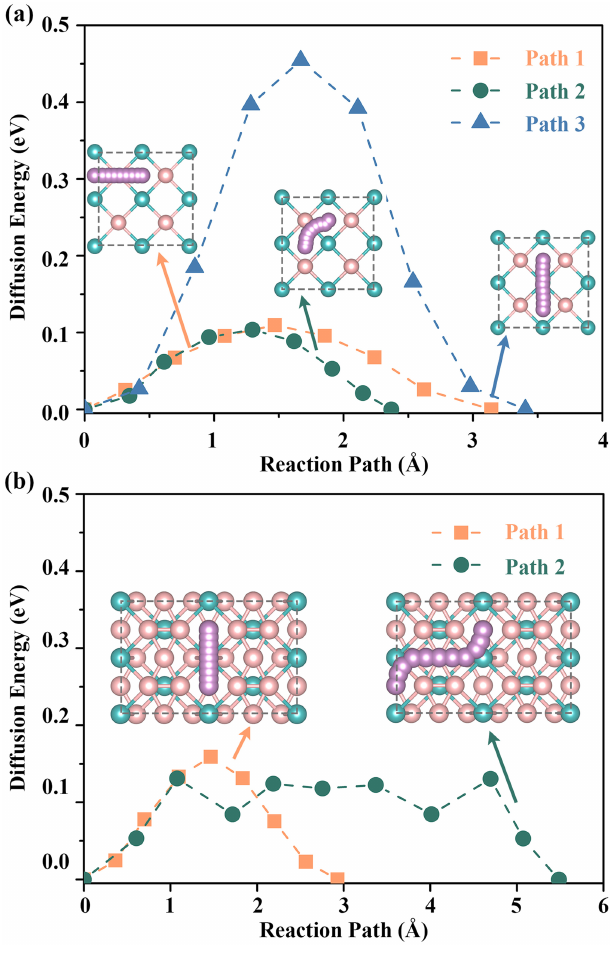
Fig. 8 Li adsorption. Li diffusion barriers on the a MoB and b MoB 3 monolayers for the diffusion pathways shown as